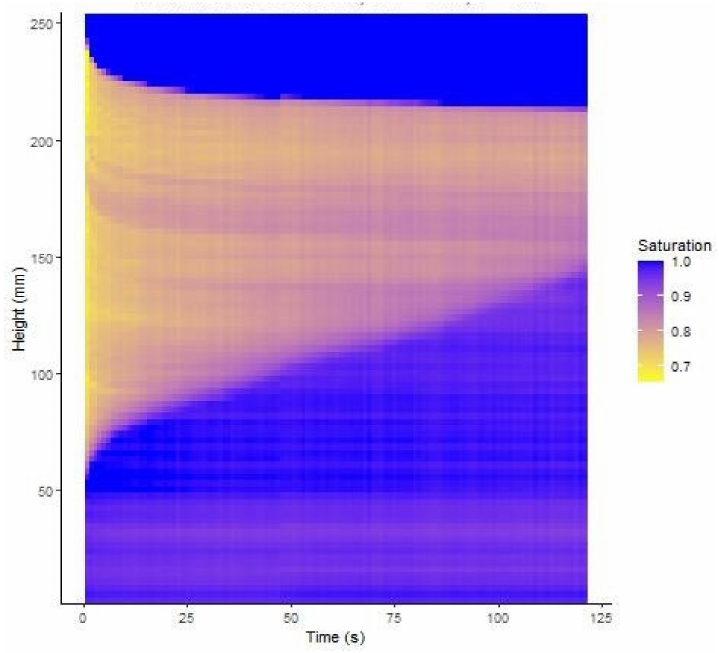
Figure 6. Evolution of saturation degree with depth in test